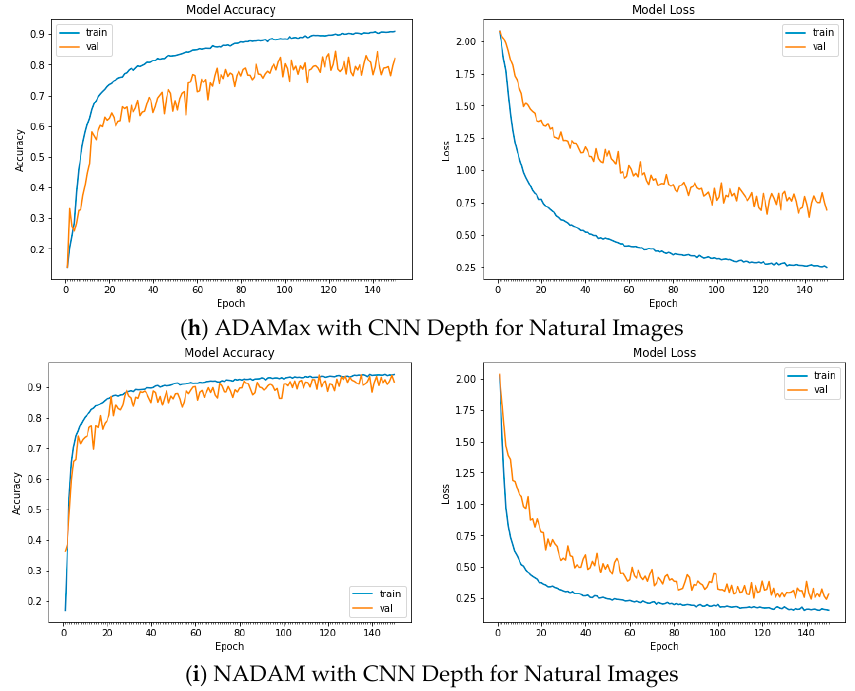
Figure A2. Plots of Train and Validation Test accuracies and losses of the CNN model with varying depth for Natural Images: ( a ) Vanilla SGD; ( b ) SGD momentum; ( c ) SGD Nesterov momentum; ( d ) ADAGrad; ( e ) RSMProp; ( f ) ADAM; ( g ) ADADelta; ( h ) ADAMax; ( i ) NADAM.